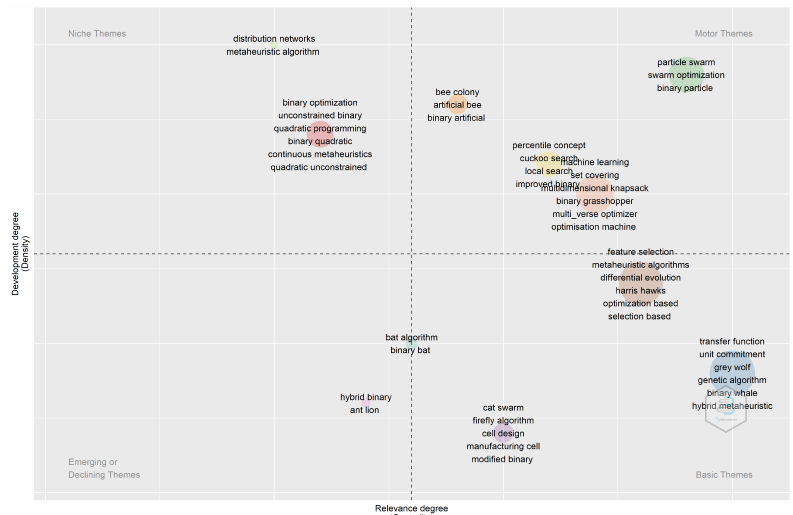
Figure 5. Clustering thematic bigrams analysis.